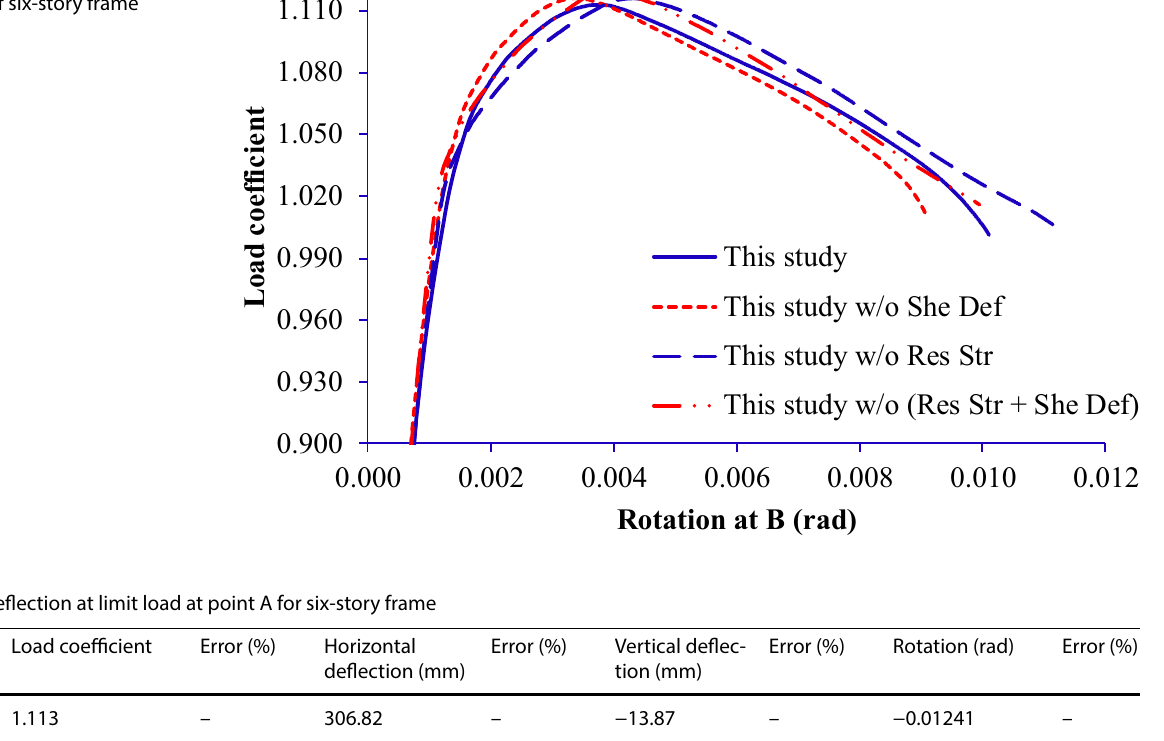
Fig. 22 Load-rotation relation- ship at B of six-story frame